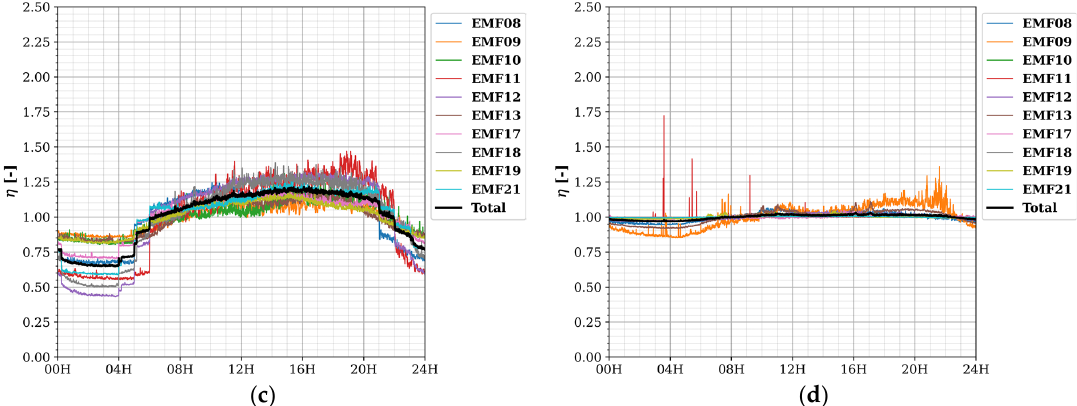
Figure 7. Diurnal temporal profiles TP D with resolution Δ t of 30 s for each fixed RF sensor (and the area total) and for different frequencies ( a ) 900 MHz; ( b ) 1800 MHz; ( c ) 2100 MHz; and ( d ) 2400 MHz. Here, η is the average power density at a certain time of the day normalized to the daily average.